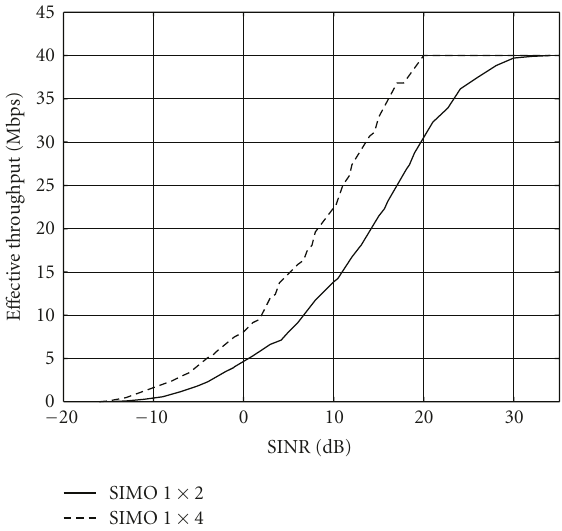
Figure 4: Link level evaluation of throughput versus SINR in LTE